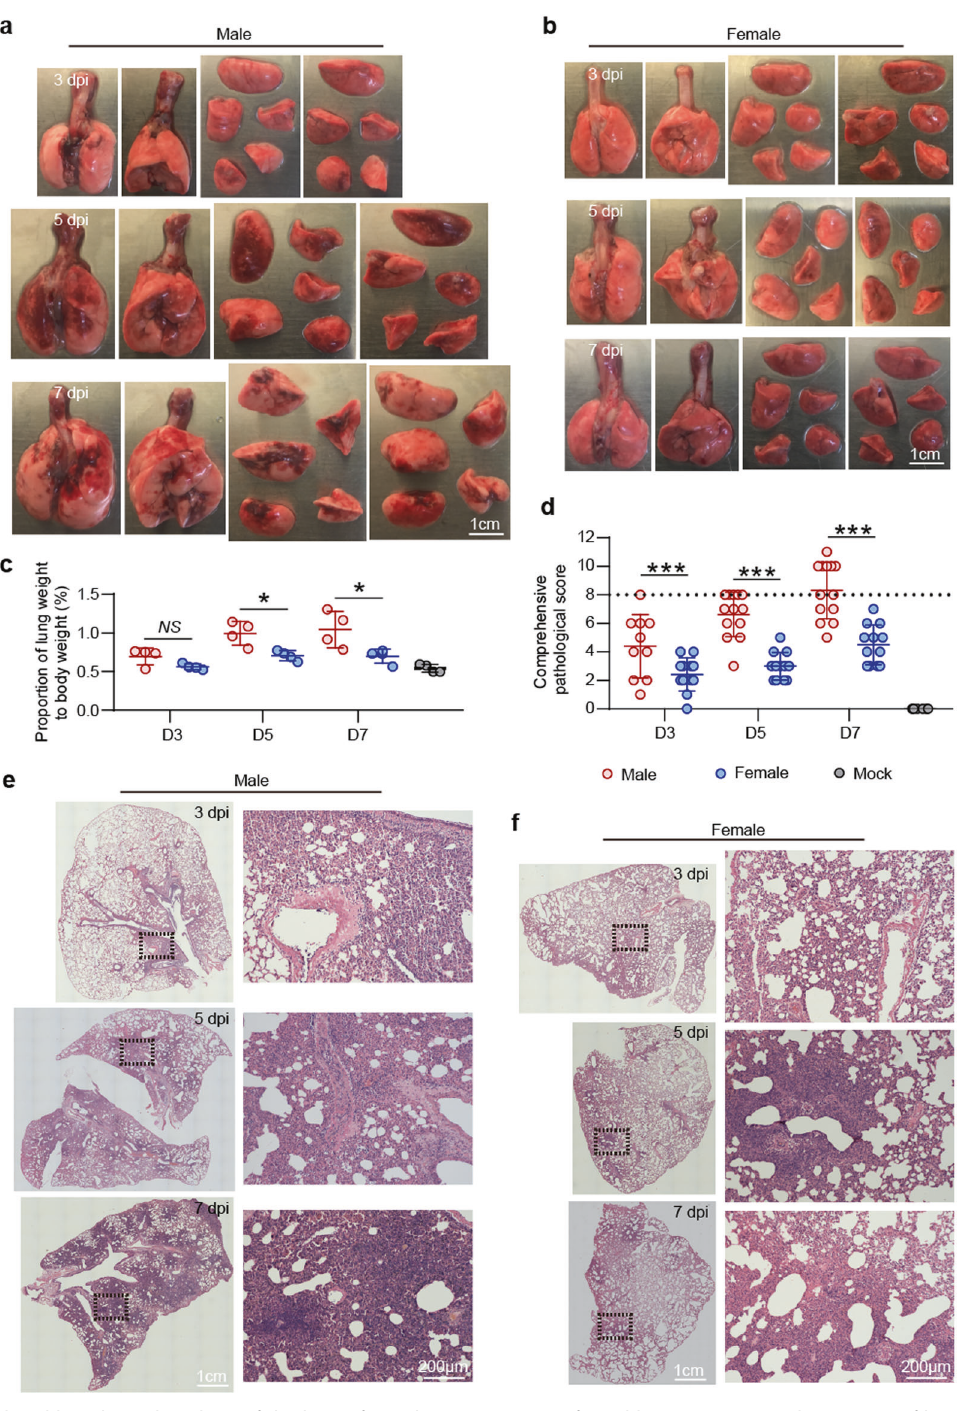
Fig. 2 Pathological and histological analysis of the lungs from the SAES-CoV-2-infected hamsters. Gross observation of lung tissues collected from a male and b female hamsters that were nasally inoculated with 10 4 PFU of SARS-CoV-2 at 3, 5, and 7 dpi, respectively (bar = 1 cm). d Ratio of lung weight to body weight of indicated male and female hamsters at 3, 5, and 7 dpi, respectively. Hamster without SARS-CoV-2 infection set as mock control ( n = 4/group). d Comprehensive pathological score of lung sections derived from H&E staining for representative lung lobes collected from e male and f female hamster that are infected with SARS-CoV-2 at 3, 5, and 7 dpi. Views of the whole lung lobes were shown in left panels (bar = 1 cm) and areas in black box were enlarged in right panels (bar = 200 μ m). Scores were determined based on the severity and percentage of injured areas for each lung lobe collected from indicated animal. Detailed images of more lung lobes were shown in Supplementary Figs. 5 and